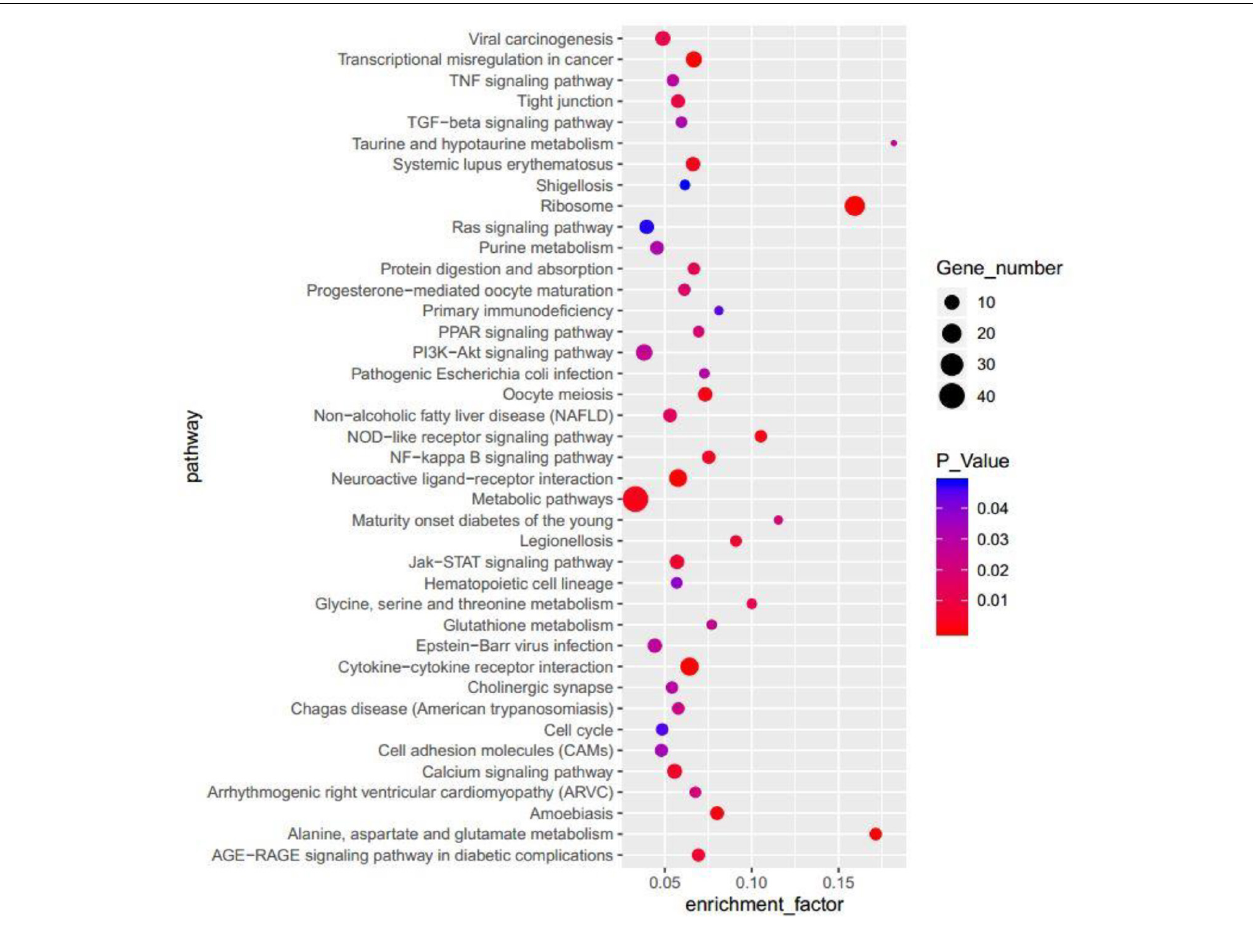
FIGURE 8 | The top 40 terms enriched in the KEGG of the